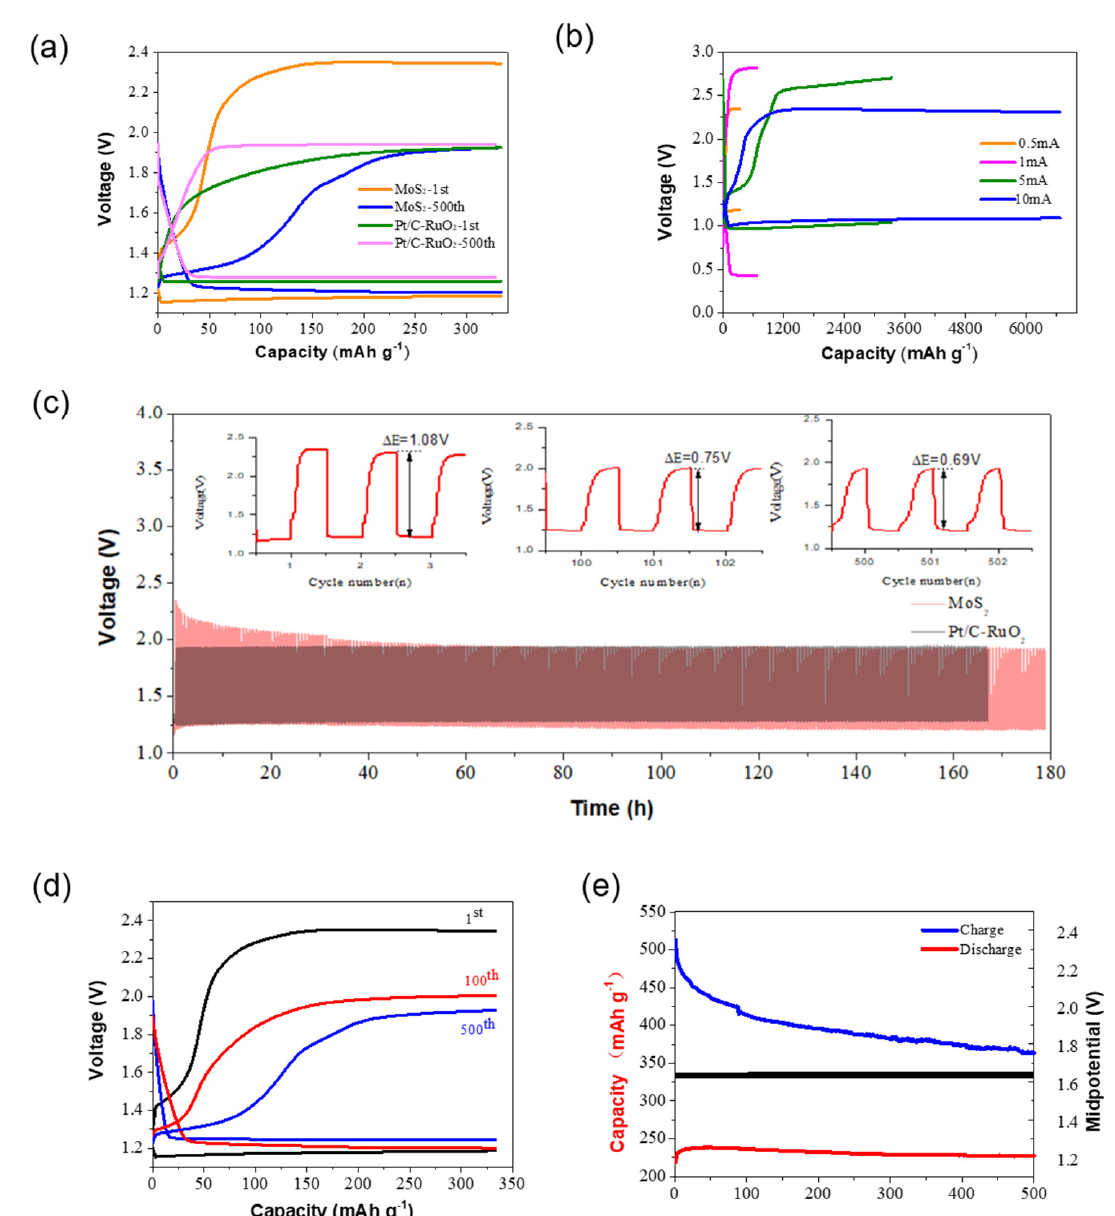
Figure 3. Electrochemical performance of the Zn–air batteries. ( a ) The discharge and charge curves of Zn–air batteries using the prepared MoS 2 catalysts and commercial Pt/C-RuO 2 catalysts at the 1st and 500th cycles, with a limited capacity of 330 mAh g − 1 , respectively. ( b ) The discharge and charge curves of the assembled Zn–air batteries using the MoS 2 catalysts at various current densities of 0.5 A cm − 2 , 1 A cm − 2 , 5 A cm − 2 , and 10 A cm − 2 , respectively. ( c ) Electrochemical cycle performance of the Zn–air batteries using the prepared MoS 2 catalysts and commercial Pt/C-RuO 2 catalysts operating at 0.5 A cm − 2 , respectively. ( d ) The discharge and charge curves of Zn–air batteries using the prepared MoS 2 catalysts at the 1st, 100th and 500th, respectively, and ( e ) corresponding to the voltage and capacity change of the Zn–air battery during the cycle.